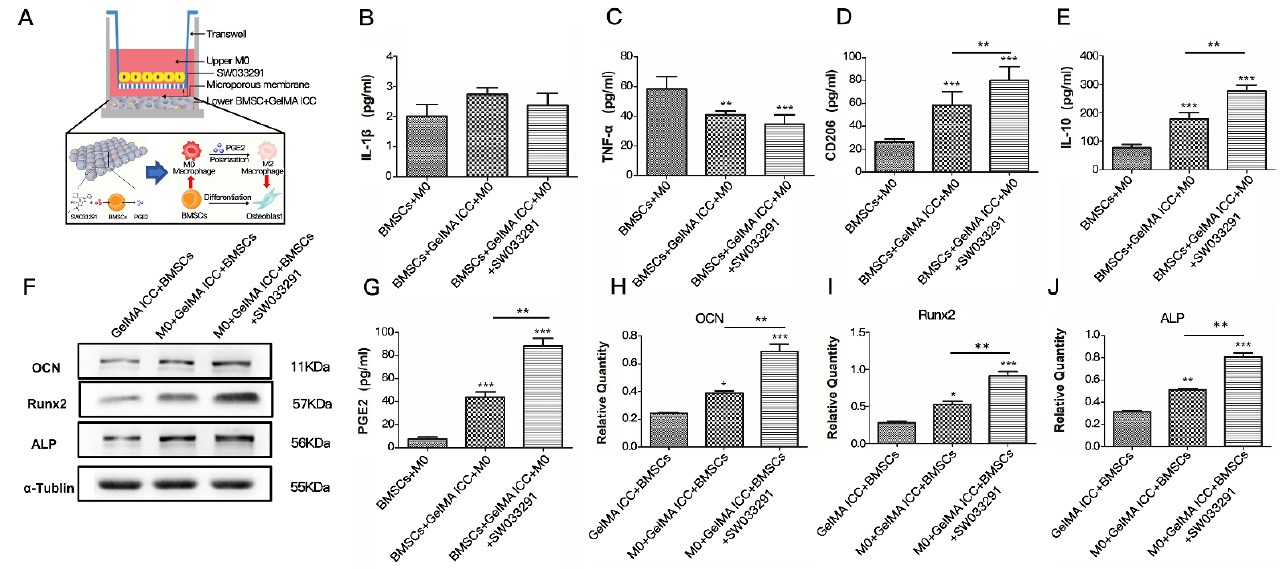
Figure 5. Effects of GelMA ICC scaffolds with SW033291 on the cytokines release and osteogenic pathway. ( A ) Schematic illustration of the crosstalk between BMSCs and macrophage in non-contact coculture system; ( B ) The IL-1 β levels in coculture; ( C ) The TNF- α levels in coculture; ( D )The CD206 levels in coculture; ( E ) The IL-10 levels in coculture; ( F ) Western blot of the OCN, Runx2 and ALP levels in BMSCs of co-cultures with different treatment; ( G ) The PGE2 levels in coculture; ( H ) The relative density of OCN band by gray value analysis; ( I ) The relative density of Runx 2 band by gray value analysis; ( J ) The relative density of ALP band by gray value analysis. Data represent mean ± standard deviation, n = 3. For cytokines release, the BMSCs + M0 coculture was served as the control. For Western blot analysis, the BMSCs seeded on GelMA ICC was served as the control, * p < 0.05 significant difference as compared groups. ** p < 0.05 significant difference as compared groups. *** p < 0.01 vs. the control group.